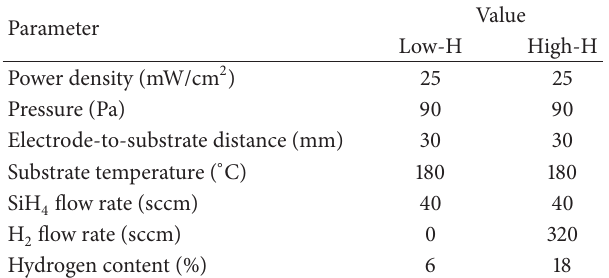
Table 2: Deposition conditions of low-H and